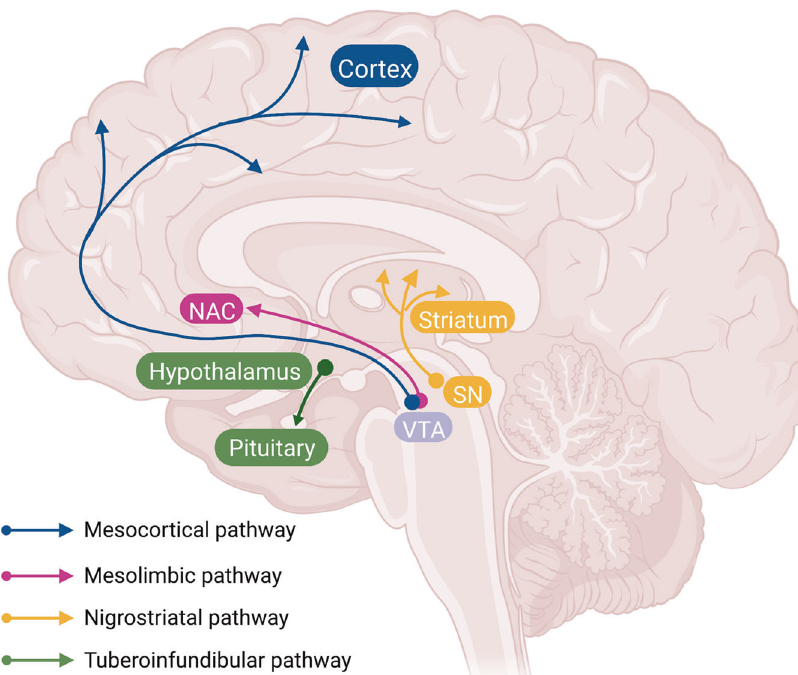
Fig. 2 Dopaminergic pathways in the brain. Dopaminergic pathways in the brain include the mesocortical pathway (blue) from dopaminergic neurons in ventral tegmental area (VTA) to cortex, the mesolimbic pathway (red) from VTA to nucleus accumbens, the nigrostriatal pathway (yellow) from substantia nigra to the striatum, and the tuberoinfundibular pathway (green) from hypothalamic nuclei (arcuate nucleus and periventricular nucleus) to the pituitary. The fi g was modi fi ed from that by Klein et al. (2019) 11